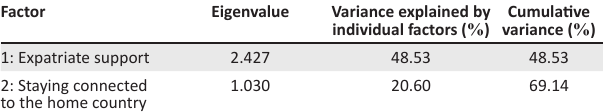
TABLE 1: Factor matrix with sorted rotated factor loadings. Question number